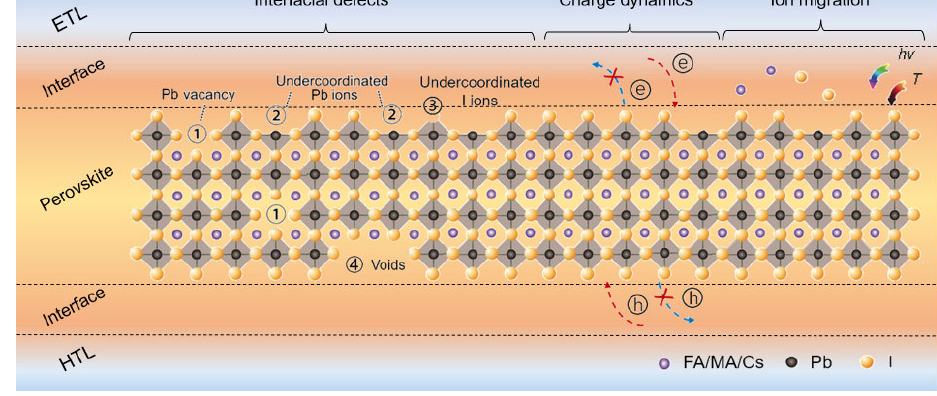
Figure 1 Schematic illustration of issues at the interface in inverted PSCs.